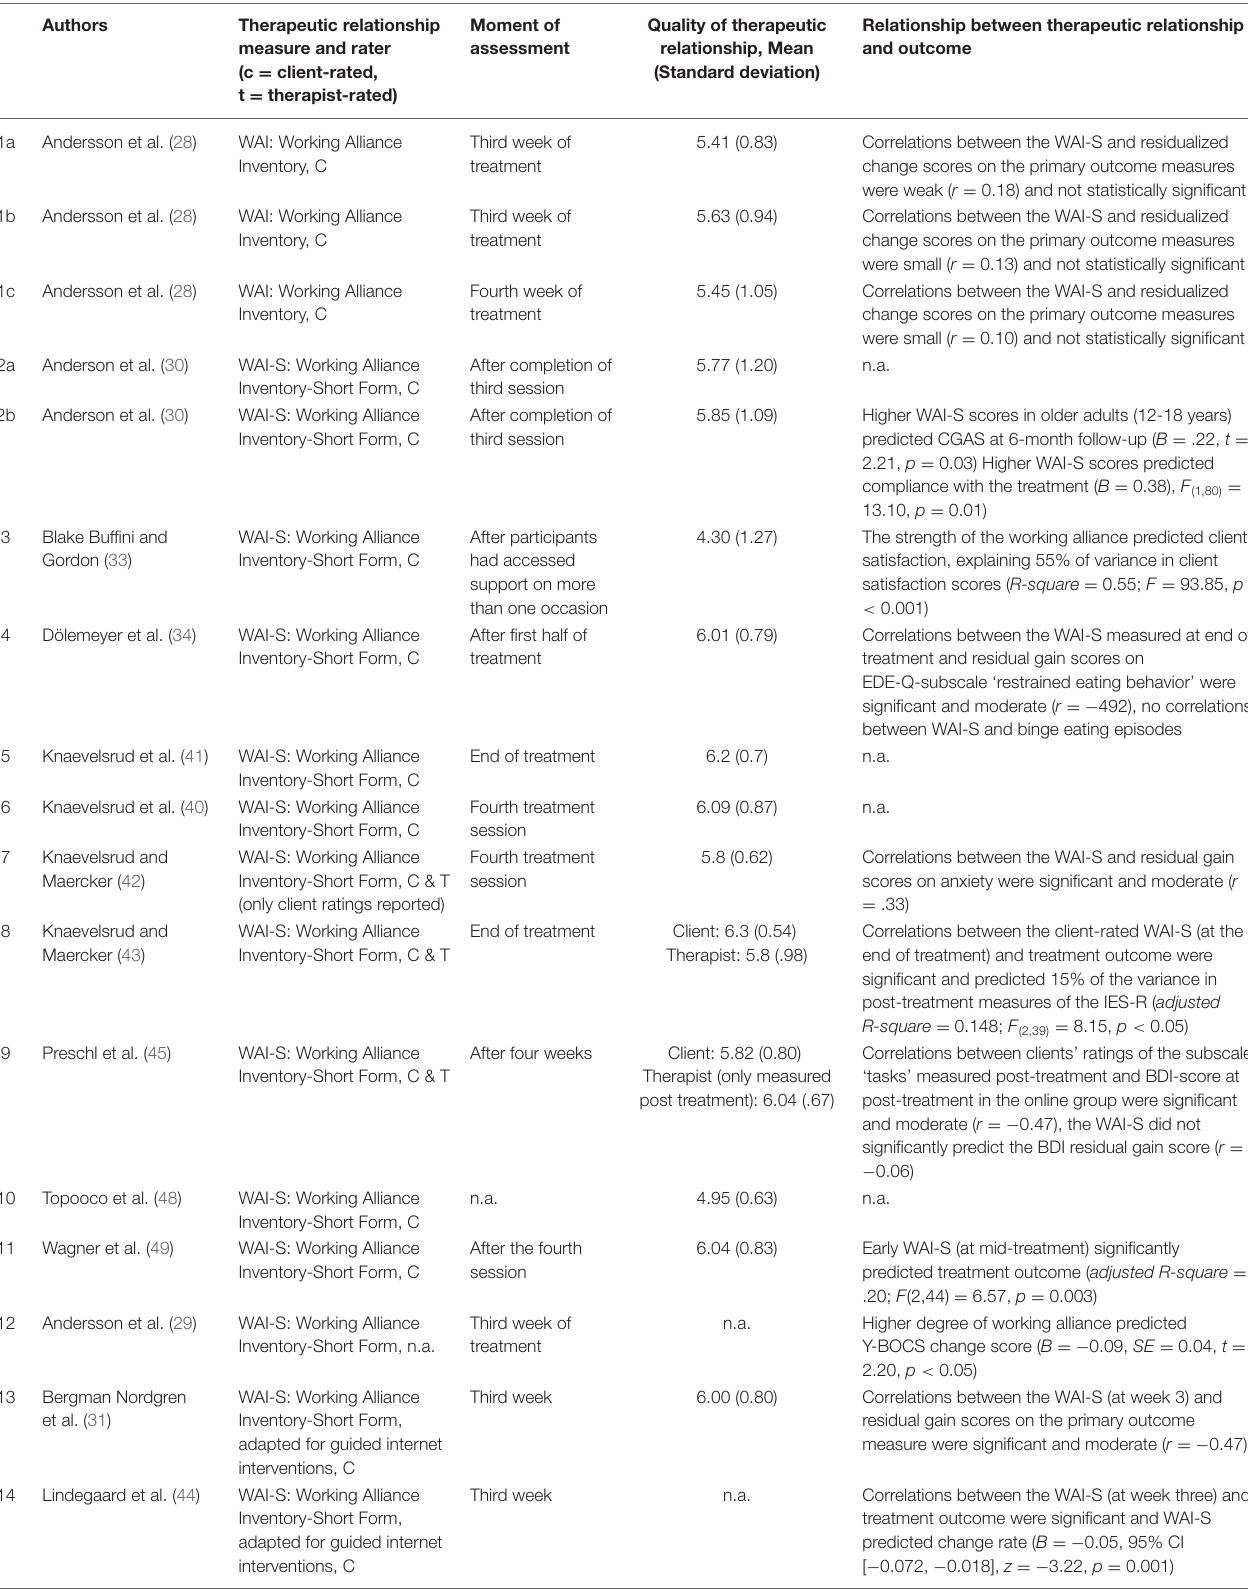
Therapeutic relationship measure and rater